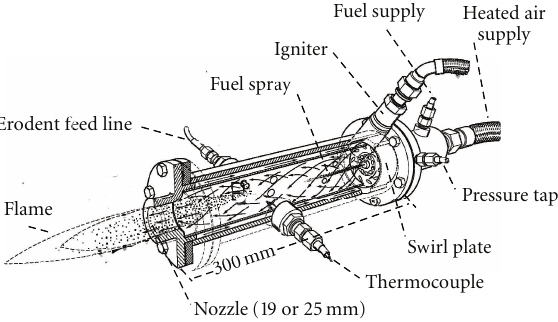
Figure 1: Schematic of an unducted burner-erosion